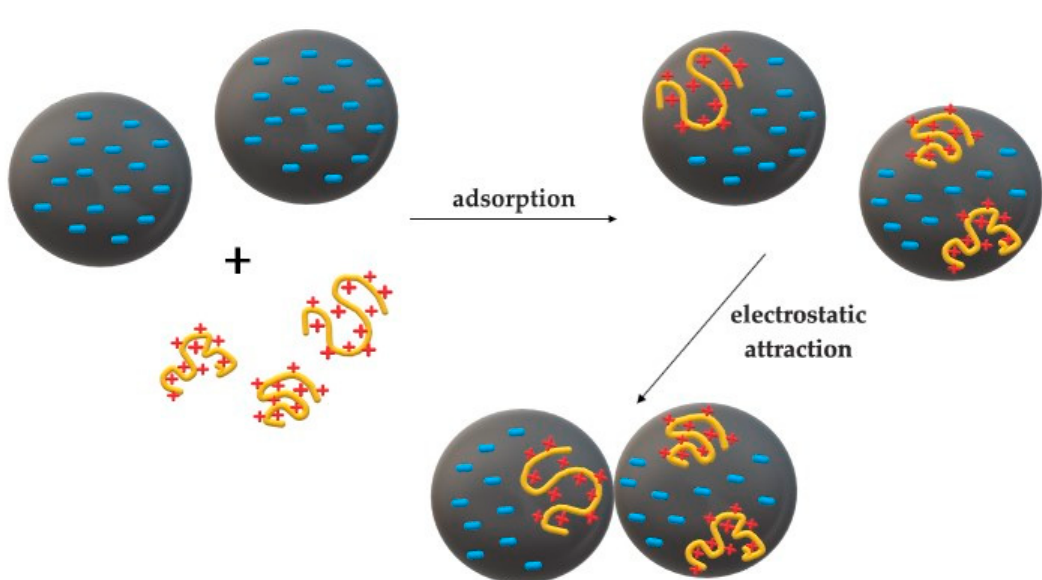
Figure 3. Mechanism of electrostatic patch model for flocculation (according to Bolto [6]).